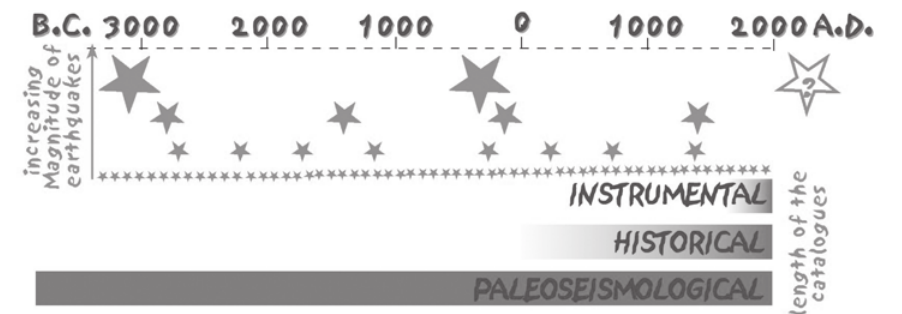
Fig. 2. Length of different types of seismic records compared with earthquake recurrence intervals on individual faults in the Mediterranean area. Note that, because of the relatively long recurrence intervals of large earthquakes typical of this area (1000 or more years), the historical and instrumental records may miss evidence of large earthquakes. In the best cases the historical record may contain evidence for one inter-event interval ( i.e . two events on the same